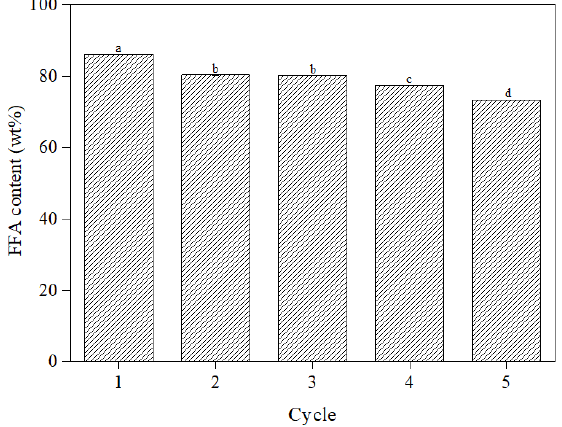
Figure 4. Effect of Lipozyme® RM IM recycling, in 6 hours of reaction, temperature of 55 °C, stirring rate of 400 rpm, 75% buffer solution (based on the oil mass), and an enzyme concentration of 10% (based on the substrates